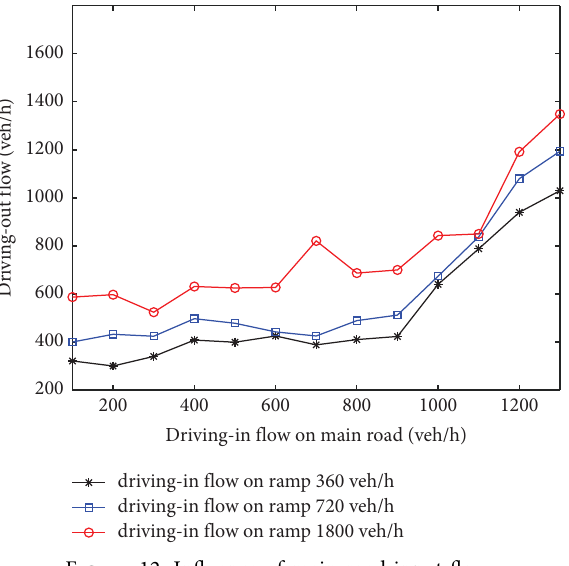
Figure 10: Velocities with merging vehicles.